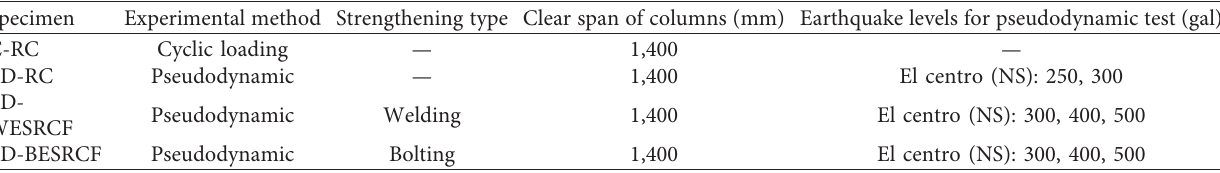
Table 3: Summary of the test conditions for cyclic loading and pseudodynamic